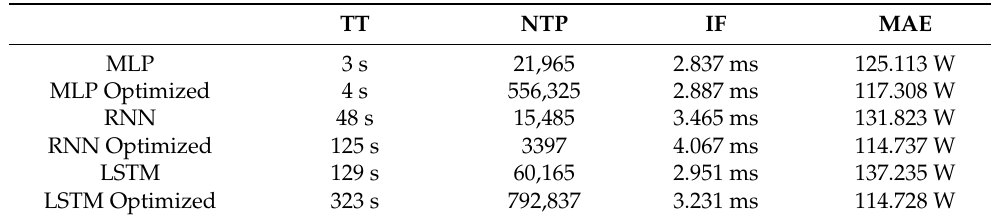
Table 3. Time of One Epoch of Training (TT), Number of Trainable Parameters (NTP), Inference Time (IF), and Mean Absolute Error (MAE) of each neural network model. TT